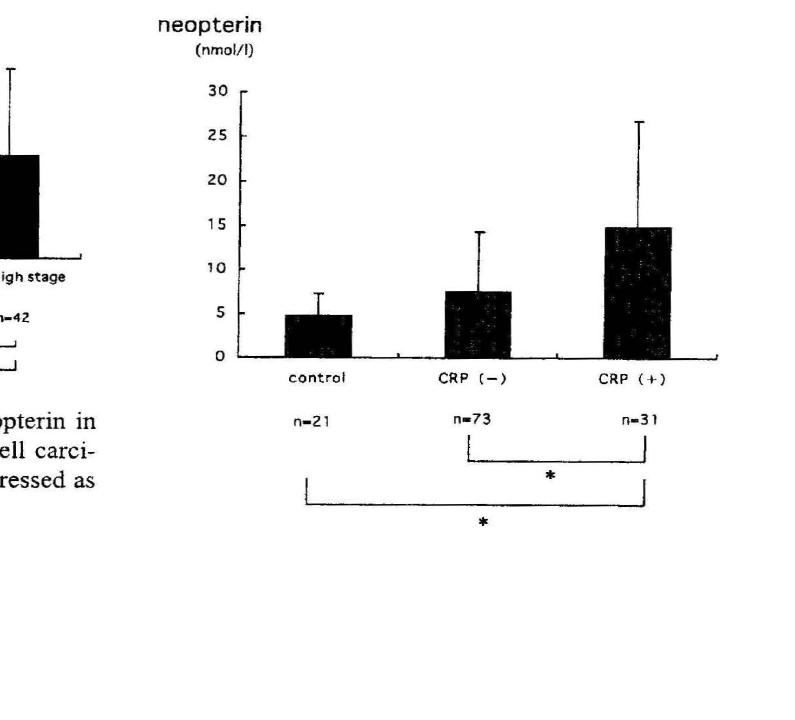
Figure 1. Mean serum concentrations of neopterin in normal individuals and patients with renal cell carci nomas of low-and high-stage. Values are expressed as mean ± SD. *P<O.OOOS. PteridineslVol. II /No.4